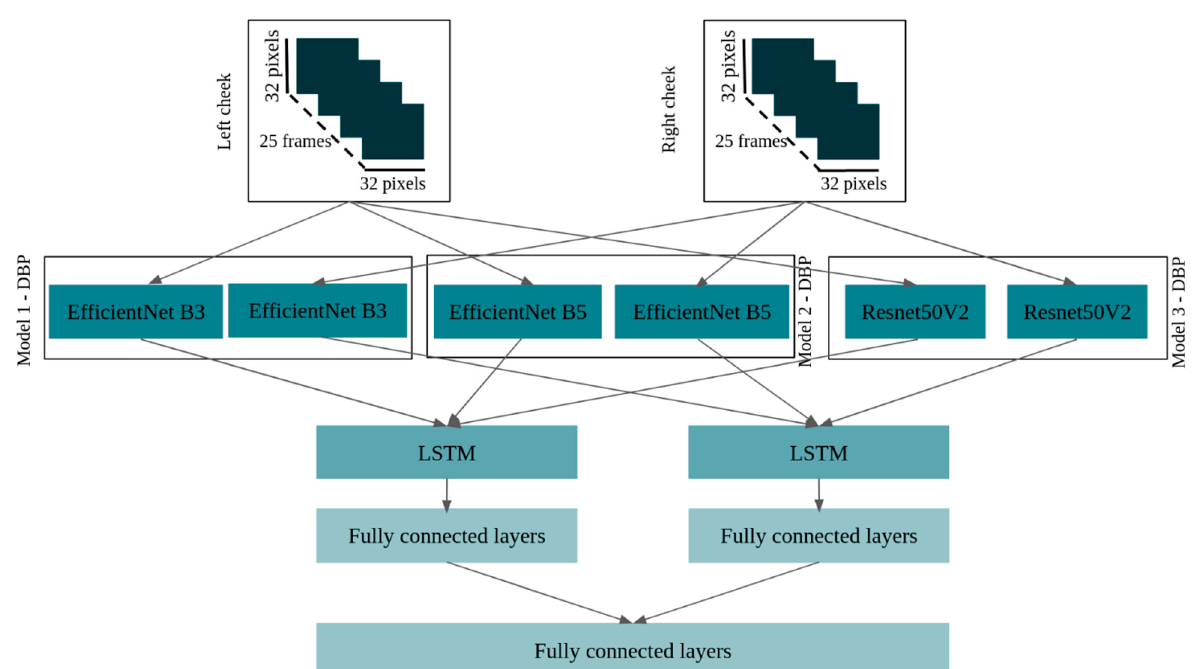
Figure 7. Architecture of the three best DBP models.